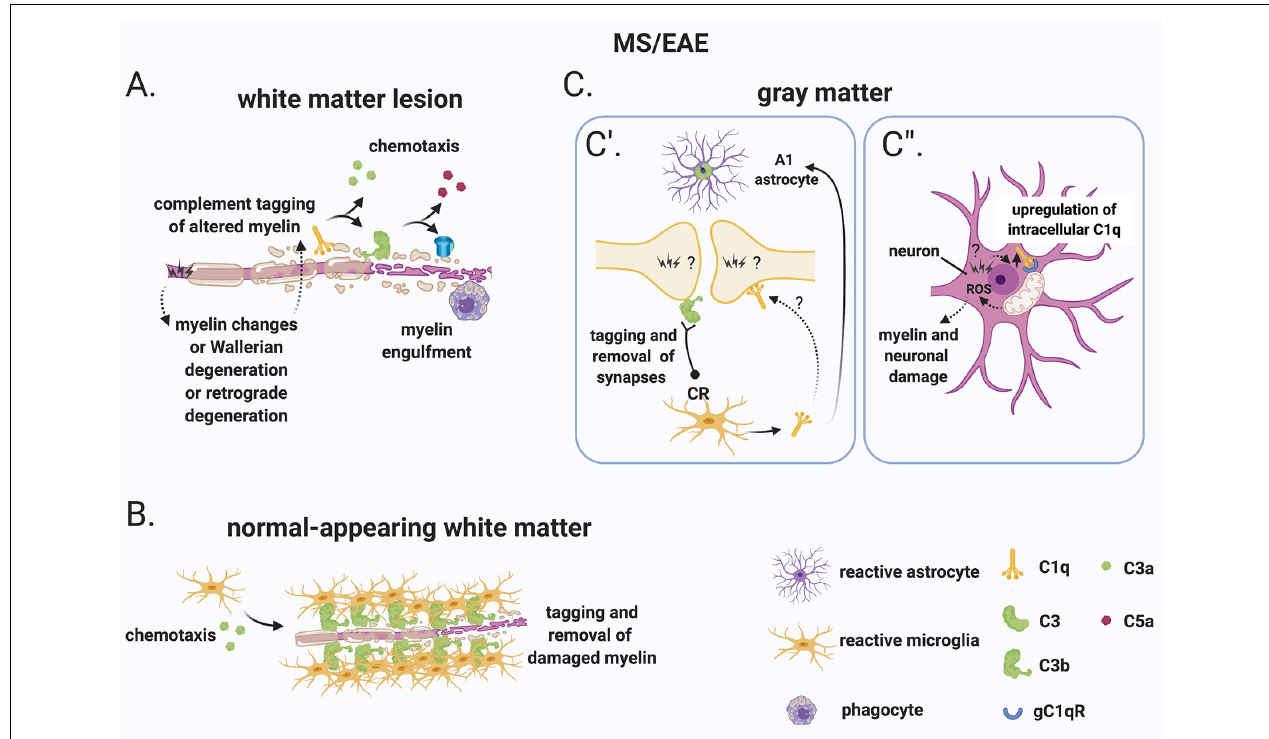
FIGURE 5 | A role for complement in the “inside-out” paradigm of demyelination and synapse loss in MS. (A) The “inside-out” model argues that a so far unknown primary cytodegenerative event leads to myelin changes or Wallerian degeneration or retrograde degeneration which exposes altered highly antigenic myelin epitopes. In this scenario, the complement system would participate in the secondary autoimmune and inflammatory response by tagging myelin and promoting its clearance by phagocytes. (B) In the normal-appearing white matter, complement (particularly activated C3) tags axons that may be damaged as a result of Wallerian degeneration or retrograde degeneration. C3-tagged altered myelin is then removed by clusters of microglia (also called microglial nodules). (C) In the gray matter, neurons and synapses could be potential hotspots of complement-mediated primary cytodegeneration. (C (cid:48) ) Synapses (of the visual thalamus) are tagged by C3b and engulfed by microglia. Tagging of synapses by C1q has also been reported in the MS hippocampus but its role in the early engulfment of synapses has not yet been investigated. Also, microglia-derived C1q (together with IL-1 α and TNF) induces a subtype of C3 + reactive astrocytes, termed A1 astrocytes, which are neurotoxic. (C (cid:48)(cid:48) ) Neurons upregulate C1q by an unknown trigger. C1q can then potentially bind to its receptor (gC1qR) on the surface of mitochondria triggering the production of ROS which in turn can induce myelin and neuronal damage. Abbreviations: ROS, reactive oxygen species.